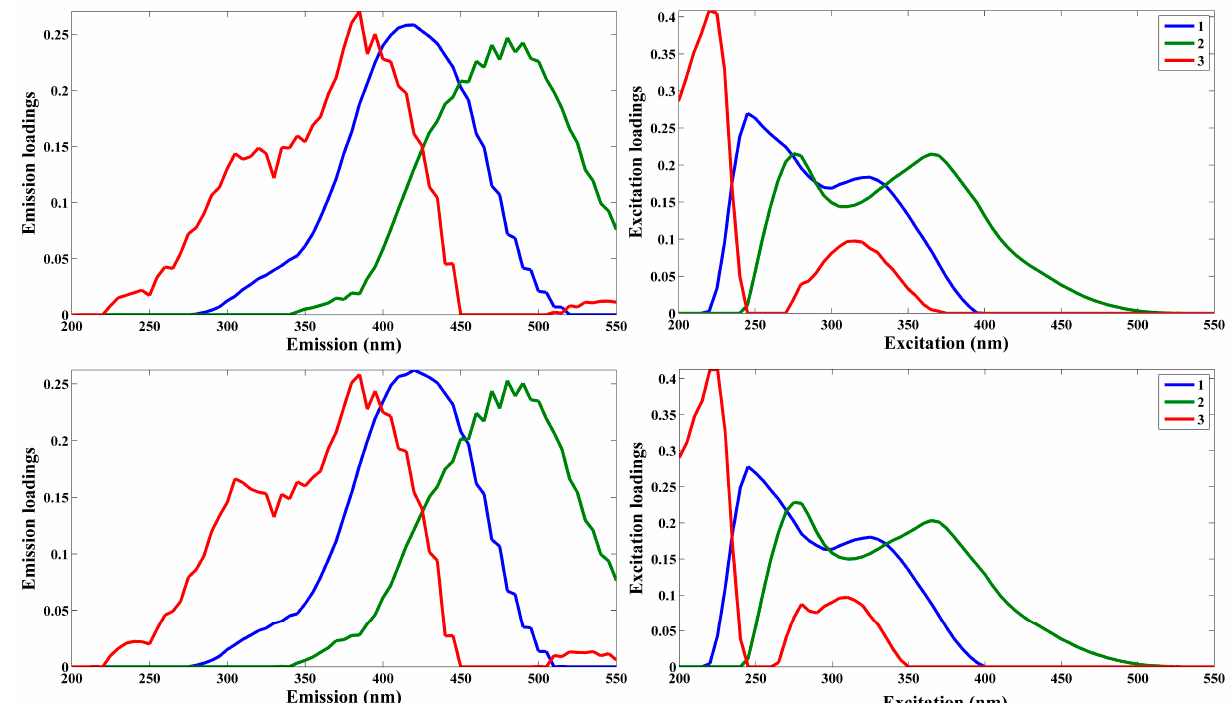
Figure 6. Split half validation of PARAFAC model A. When the fits of the splits are similar to each other and the entire model, a high stability of the model and low randomness of the fluorophores are given.